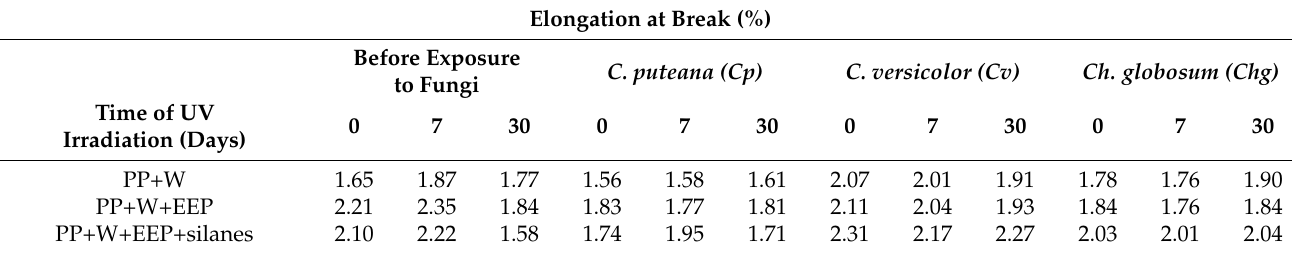
Table 5. Elongation at break of